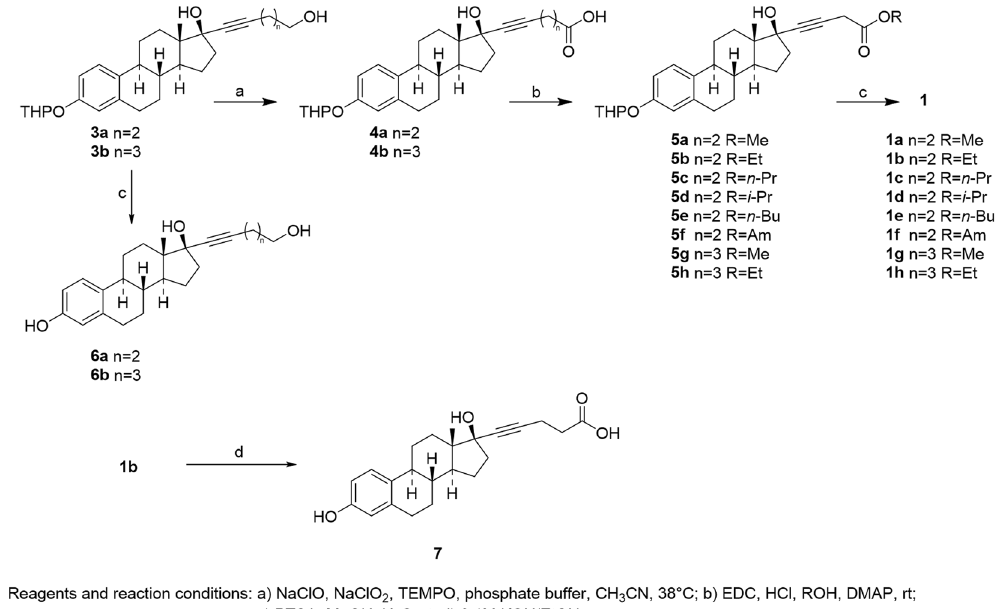
Figure 2. Reagents and reaction conditions. ( a ) NaClO, NaClO 2 , TEMPO, Phosphate buffer, CH 3 CN, 38 °C. ( b ) EDC, HCl, ROH, DMAP, rt. ( c ) PTSA, MeOH, H 2 O, rt. ( d ) 0.1 M